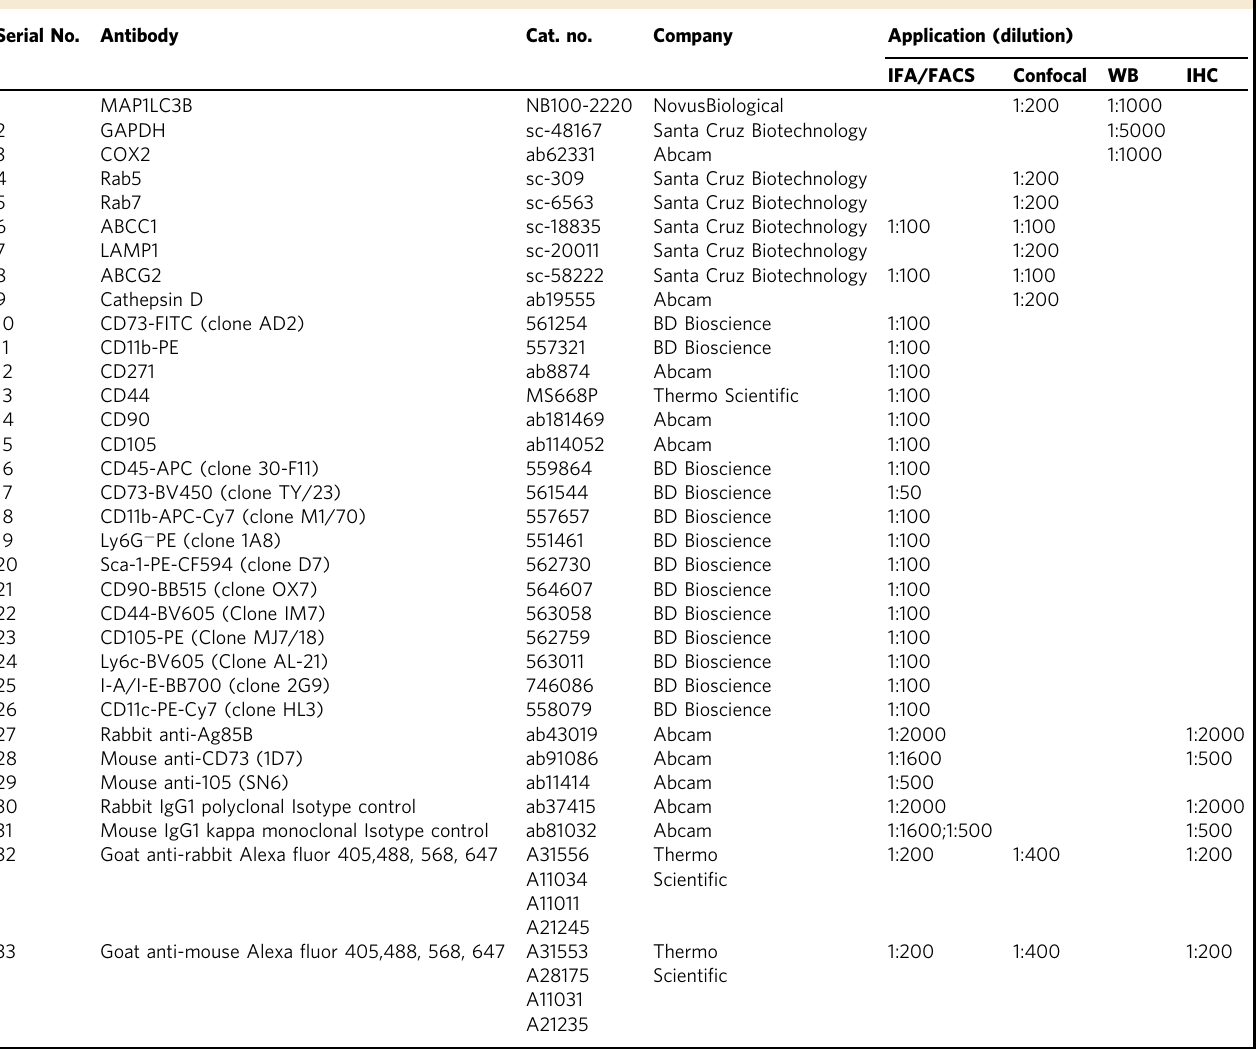
Table 1 Details of antibodies used. Serial No.